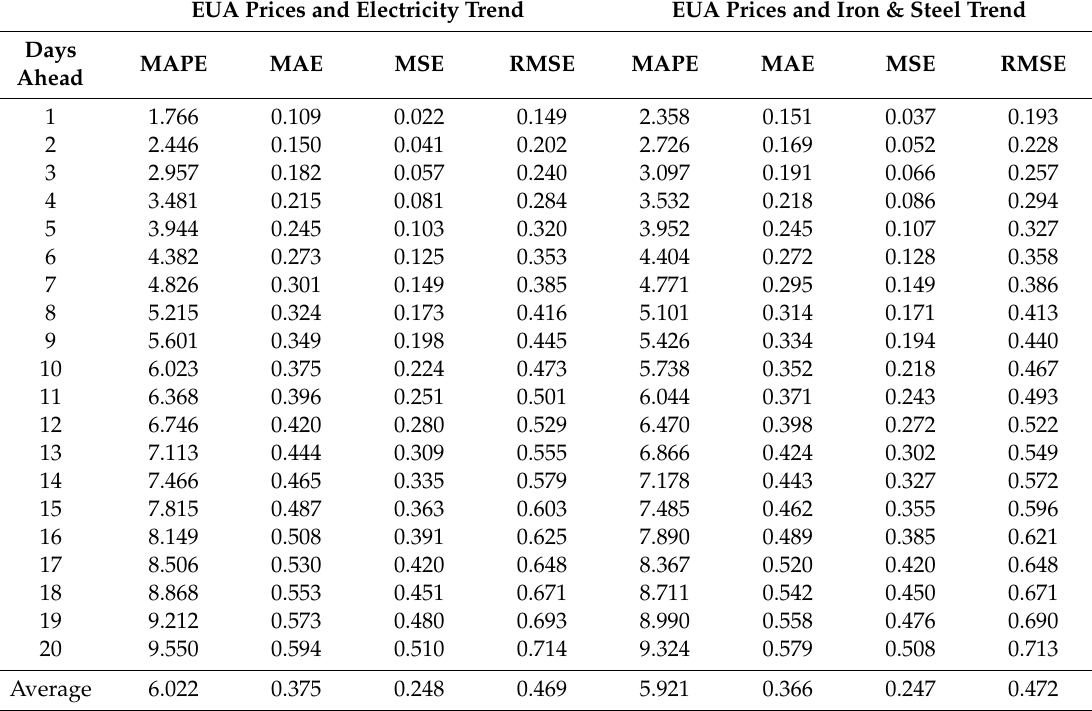
Table 7. Prediction errors of CO 2 emission allowance prices when electricity trends or iron and steel trends are also used as input variables.